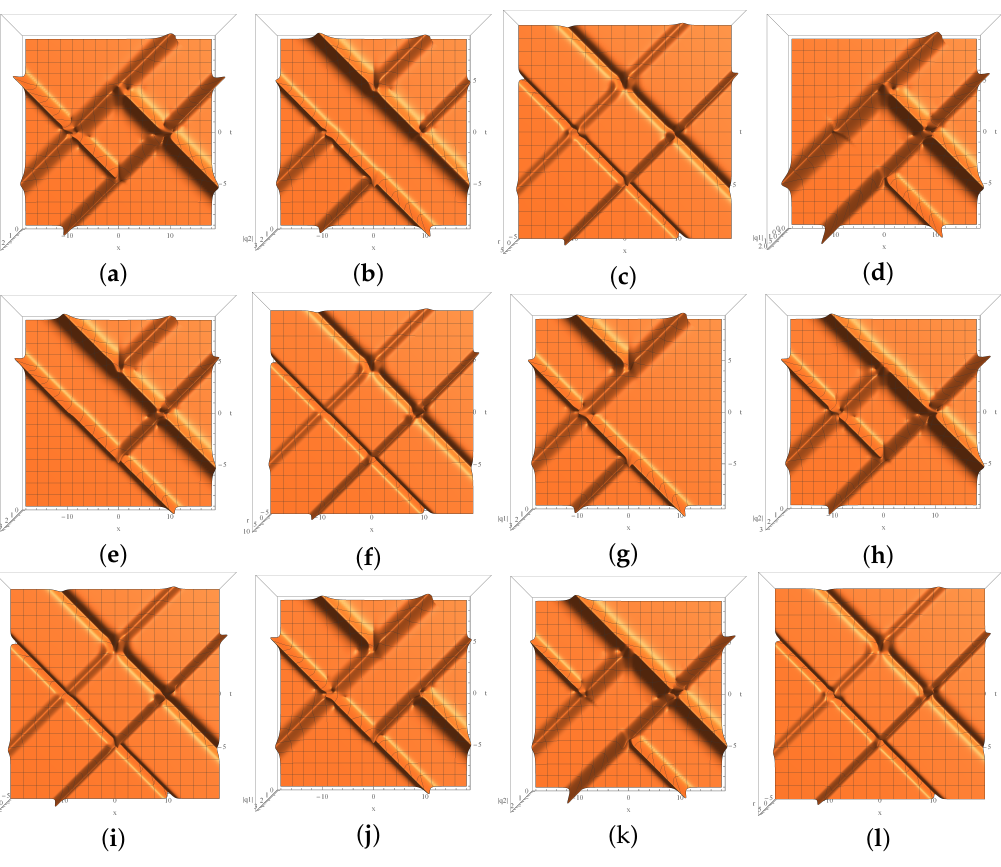
Figure 8. Some nonlinear